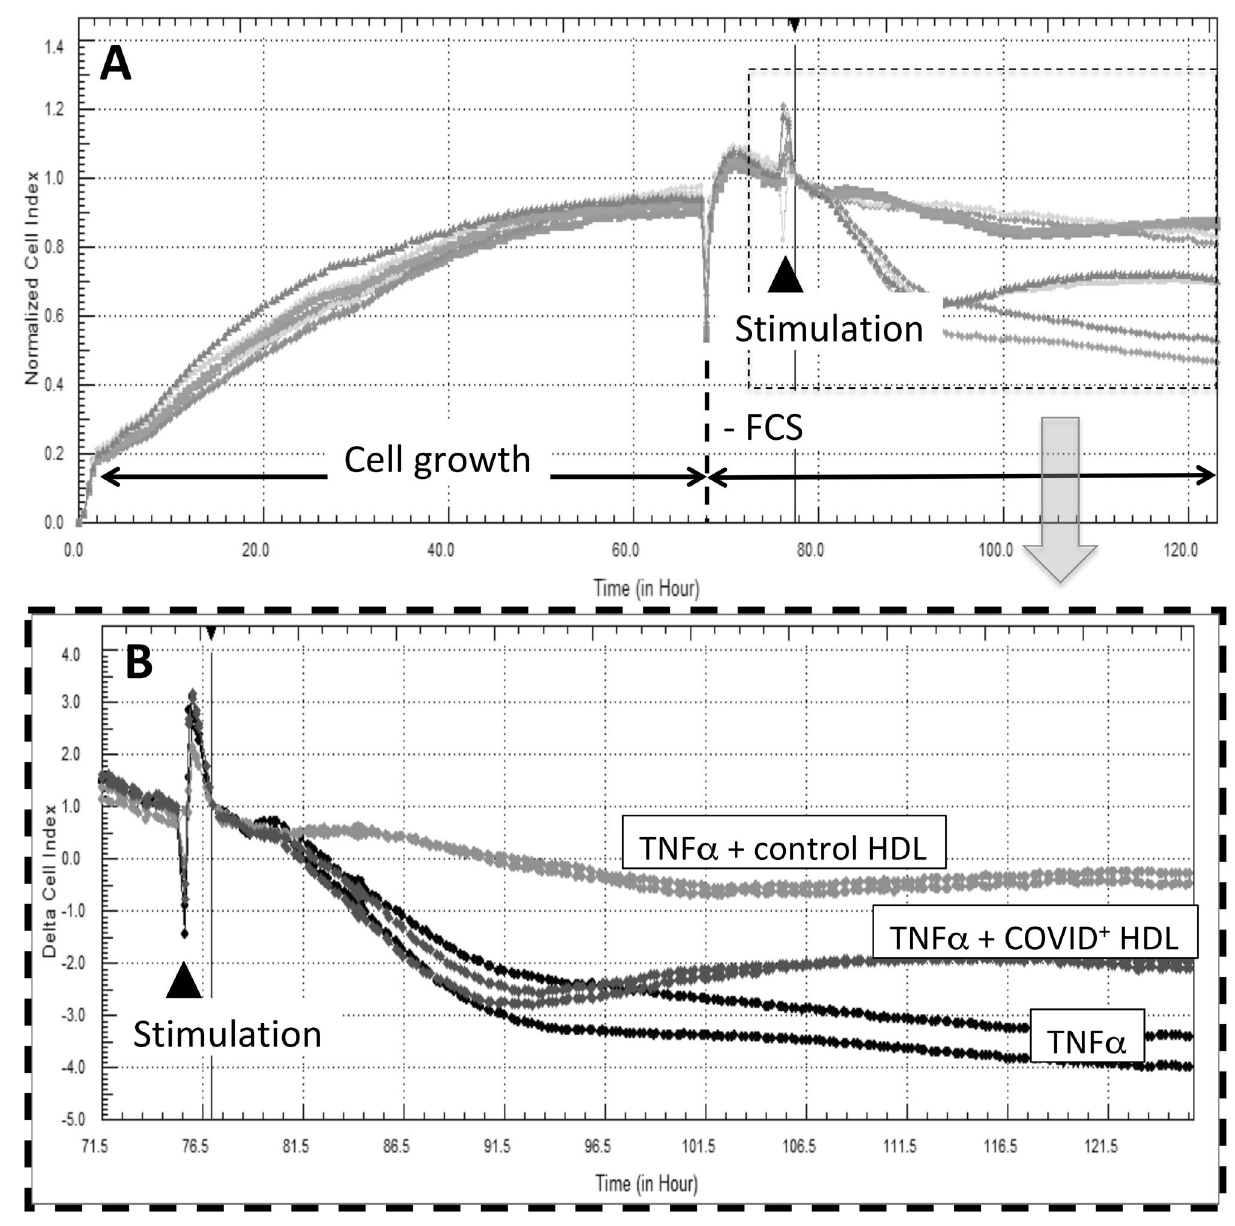
Figure 4. Real-time monitoring of HUVEC barrier dysfunction in response to TNFα+/−HDLs. Human umbilical vein endothelial cells (25,000 cells/well) were seeded on gelatin-coated xCELLigence 16 well E-plates. HDL were isolated from plasma of 16 controls and 8 D1 COVID ICU patients by ultracentrifugation and pooled into two groups: “Control HDL" and “COVID+ HDL”. The cell index was recorded continuously until confluence, when a plateau was reached [indicated cell growth in ( A )]. Cells were then serum-deprived (- Fetal Calf Serum, FCS) for 6 h and then stimulated with 30 ng/mL TNFα+/−HDLs from COVID-19 patients or controls at 0.2 mg/mL. Cell indexes were normalized after stimulation [as indicated by the vertical line, in ( A ), 30 min. after the stimulation]. A magnification showing TNFα, TNFα + COVID + HDL and TNFα + control HDL is presented in ( B ). Representative results from 2 independent experiments. HDLs isolated from each patient and matched controls (2 controls/patients) were analyzed separately (Supplementary Fig. possibility of a proteolytic degradation of this antioxidant enzyme by elastase and plasmin. Neutrophil activa- tion during COVID-19 produces elastase release potentially associated with neutrophil extracellular traps as well as an increased thrombus formation, leading to production of plasmin 19,38 . Both enzymes incubated with HDLs isolated from healthy subjects were able to degrade PON-1, suggesting that plasmin and/or elastase may participate in the decreased levels of HDL-associated PON-1. Conversely, other proteins were found to be more abundant in HDLs from COVID-19 patients, such as SAA-1 and 2, alpha-1 antitrypsin (AAT) and alpha-1 acid glycoprotein 1, considered as acute phase proteins. In a previous study, we reported an increased abundance of